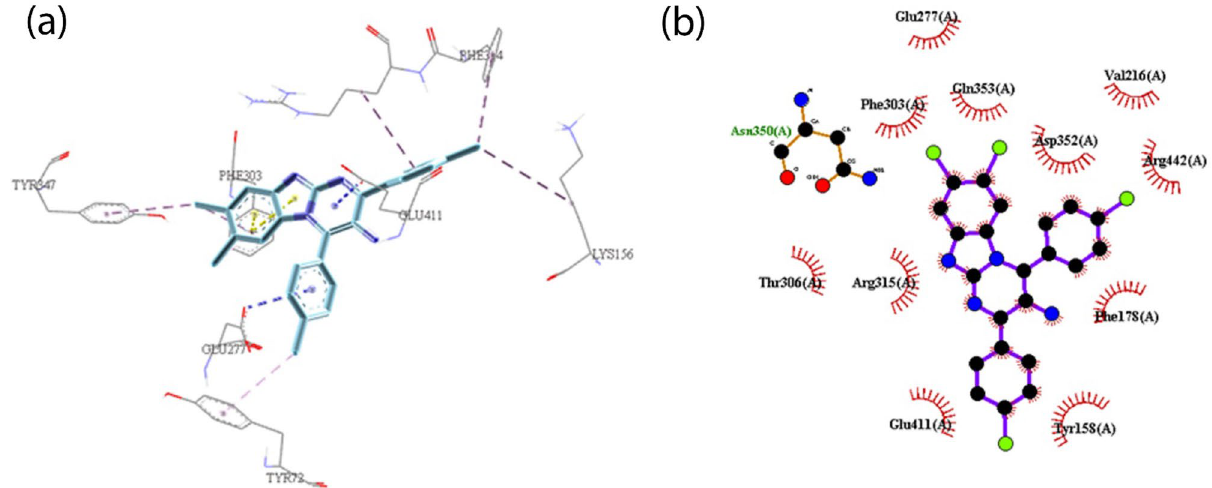
Figure 6. ( a ) The 3D and ( b ) 2D predicted binding mode of the compound 3ad in the active site pocket (π–π: yellow, π-Anion: blue, π-cation: red, hydrophobic: pink). *This figure was created by using Discovery Studio 4.0 Client (https:// disco ver. 3ds. com/ disco very- studio- visua lizer- downl oad) and LigPlot (https:// www. ebi. ac. uk/ thorn ton- srv/ softw are/ LigPl us/ downl oad. html).